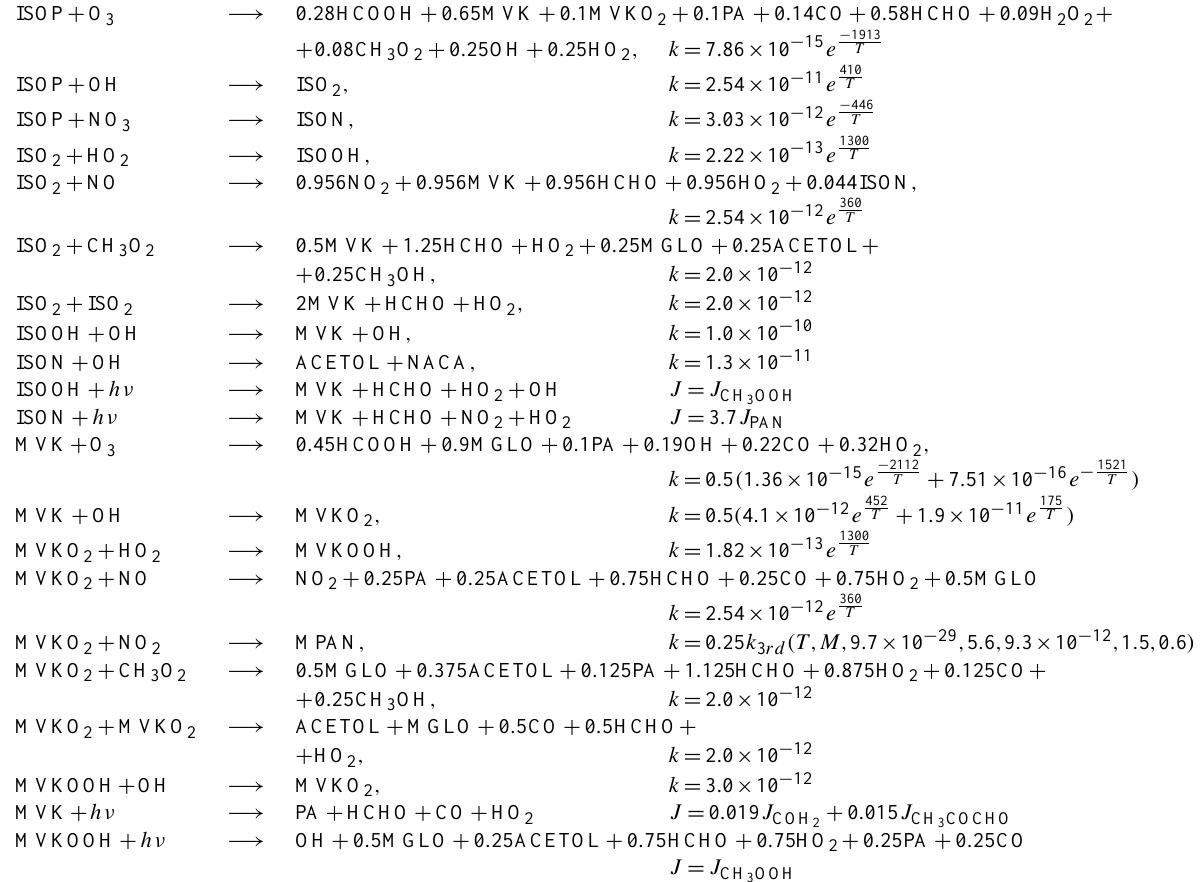
Table 5. Isoprene mechanism in MECCA. The entire chemical mechanism is described in the accompanying Supplement. ISOP + O 3